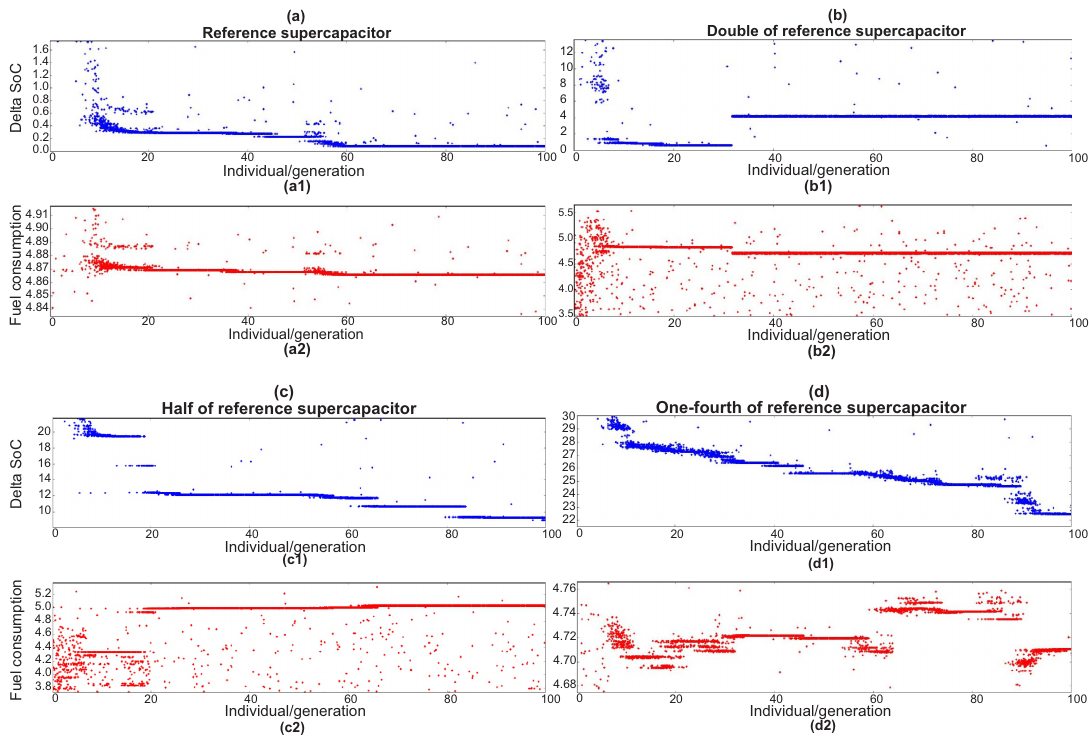
Figure 21. Objective function convergence for ( a ) the reference supercapacitor, ( b ) double the reference supercapacitor, ( c ) half the reference supercapacitor and ( d ) one-fourth the reference